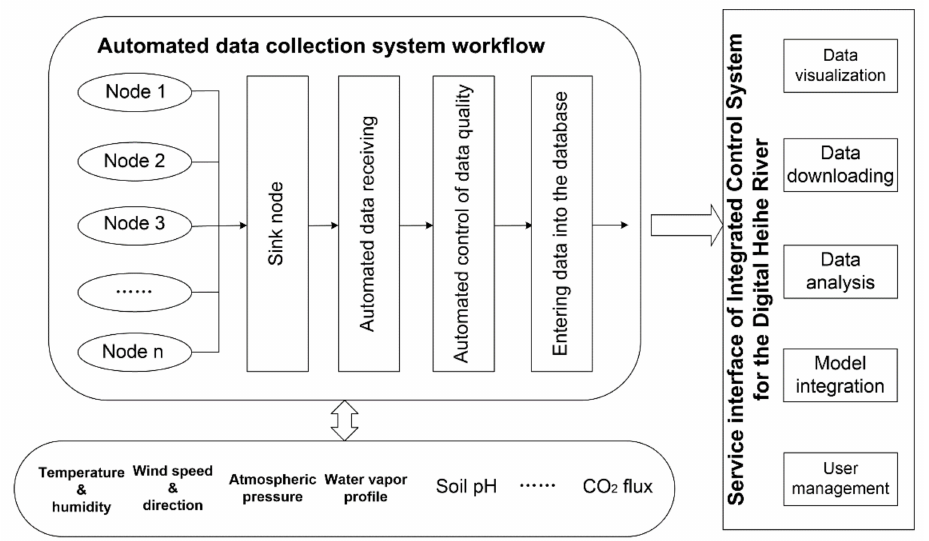
Figure 1. Framework of the